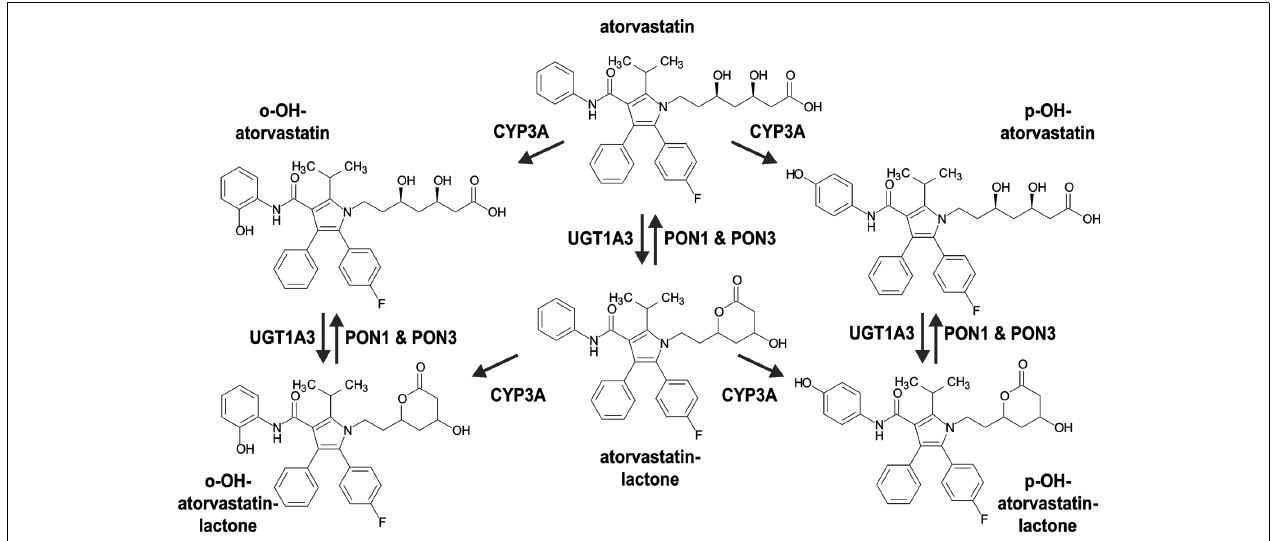
FIGURE 9 | Proposed pathway for the metabolism of atorvastatin in human liver including Hydroxylation by CYP3A enzymes, Lactonization by UGT1A3, and Hydrolysis of Lactones by PON1 and PON3.